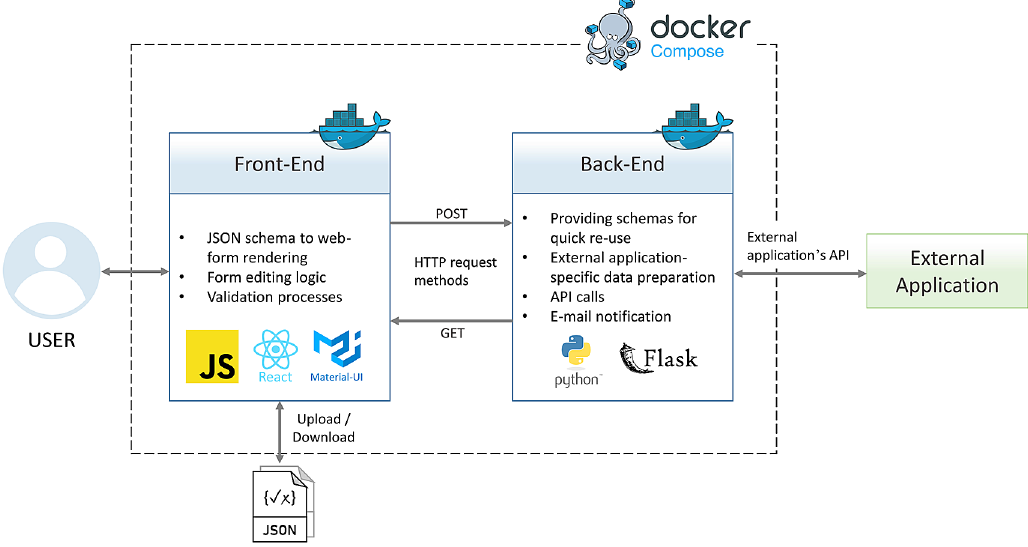
Figure1.OverviewofAdamant ’ ssoftwarearchitecture. API,ApplicationProgrammingInterface;JSON,JavaScript Object Notation; HTTP, Hypertext Transfer